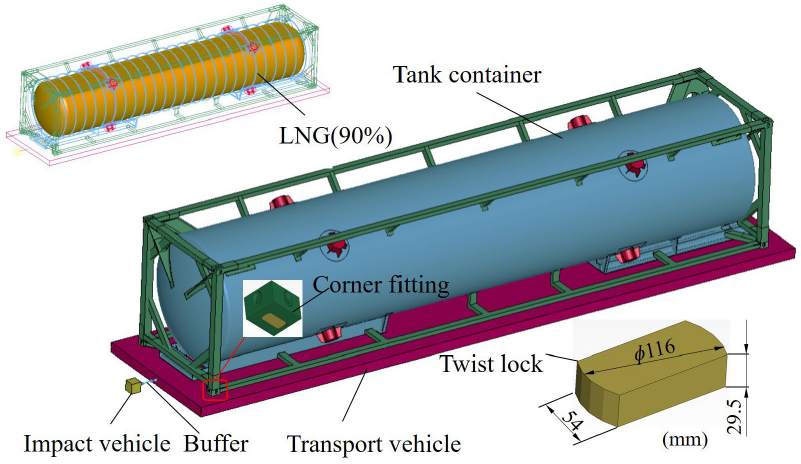
Figure 7. Geometry of the impact vehicle and the transport vehicle created in LS-DYNA and Ansys. Table 4. Mass of each model component.